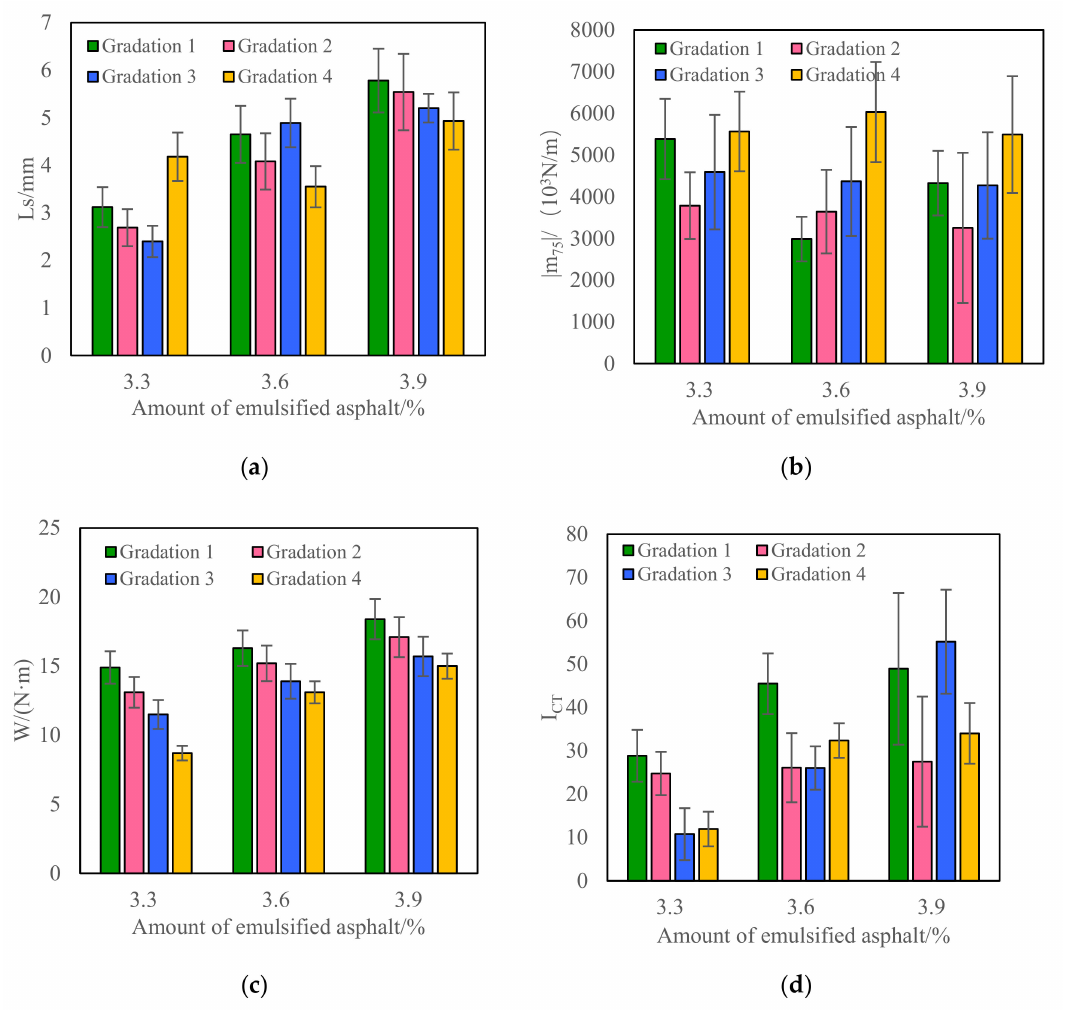
Figure 4. Low-temperature performance test results of CRM with different gradations and emulsified asphalt contents (IDT test). ( a ) Ls; ( b ) |m 75 |; ( c ) W; ( d ) I CT